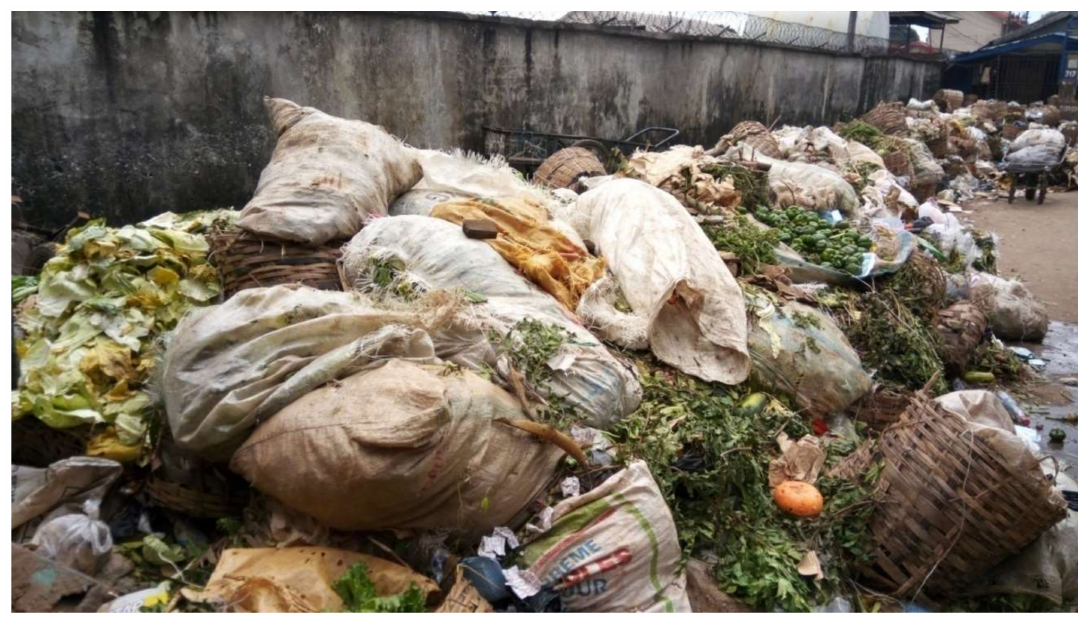
Figure 1. Waste heap at the D-line fruit and vegetable market, Port Harcourt,